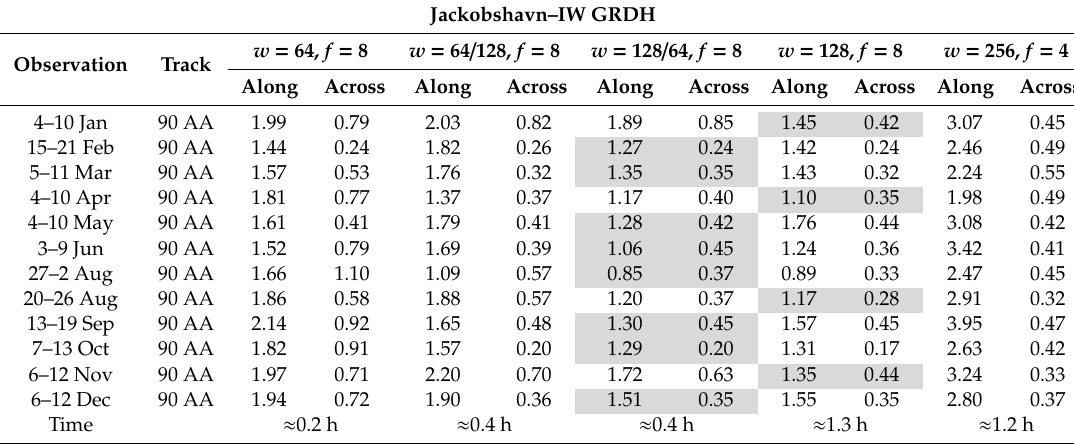
Table 9. JAK, IW GRDH product class experiments, RMSE (expressed in m / day) with respect to available literature data measured along selected along / across flow